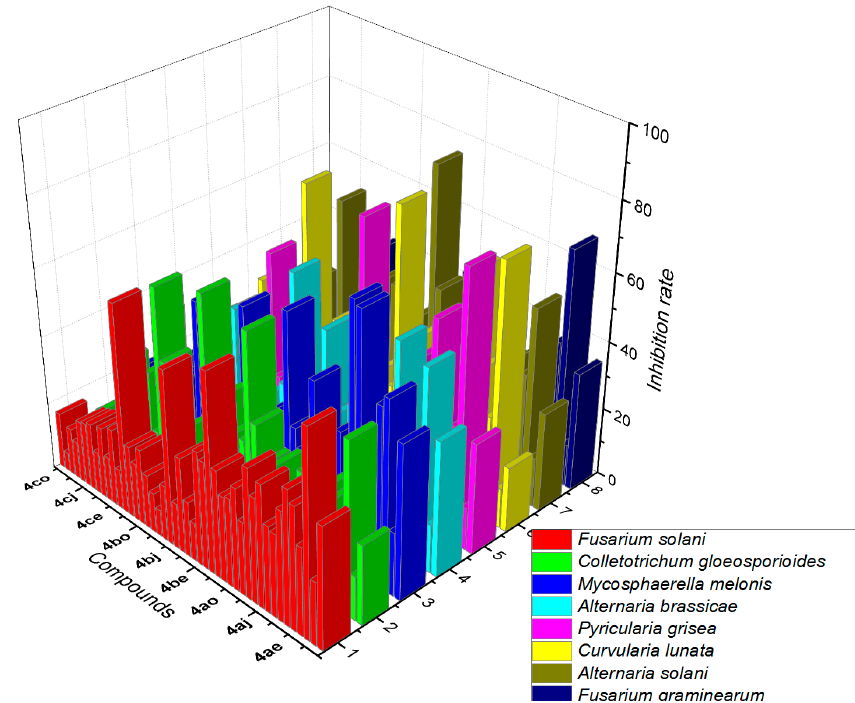
Figure 4. Antifungal activities of compounds 4aa – 4co at 100 μ